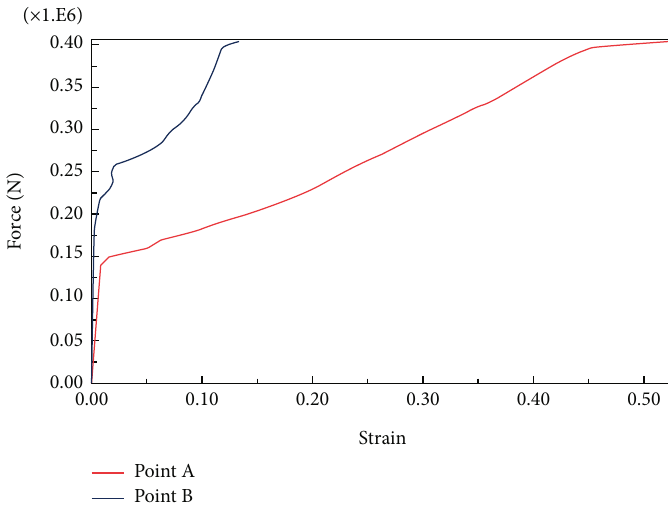
Figure 15: Force-strain diagram in locations A and B.